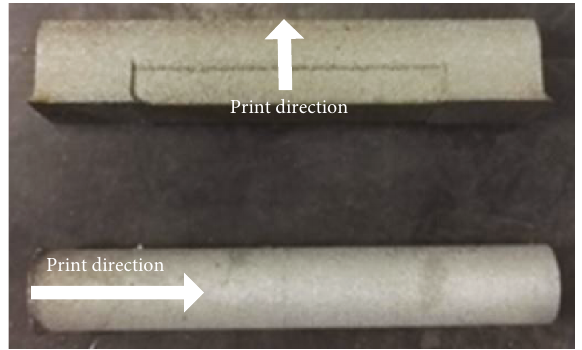
Figure 3: The print direction of